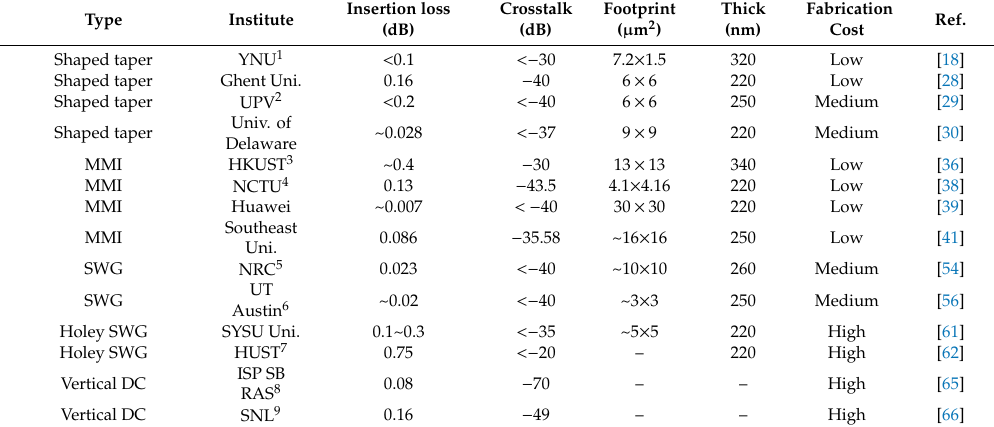
Table 1. Comparisons of di ff erent silicon waveguide crossing designs.